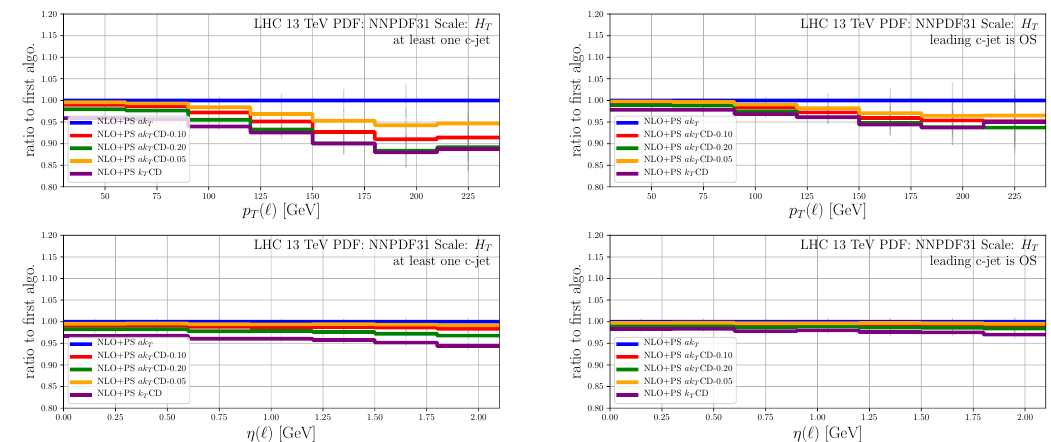
Figure 9 . Differential distributions in the transverse momentum (top) and the rapidity of the √ charged lepton (bottom) for the process pp → W + j at s = 13 TeV. All results are at NLO c QCD+PS accuracy. The left-hand side plots are for charge agnostic c-jet while the right-hand side ones are for the leading jet being of OS type. Various definitions of the flavored anti- k algorithm T are compared. In addition, these predictions are compared to the nominal flavored k algorithm as T well as the standard anti- k algorithm. Vertical bars show statistical uncertainty. T